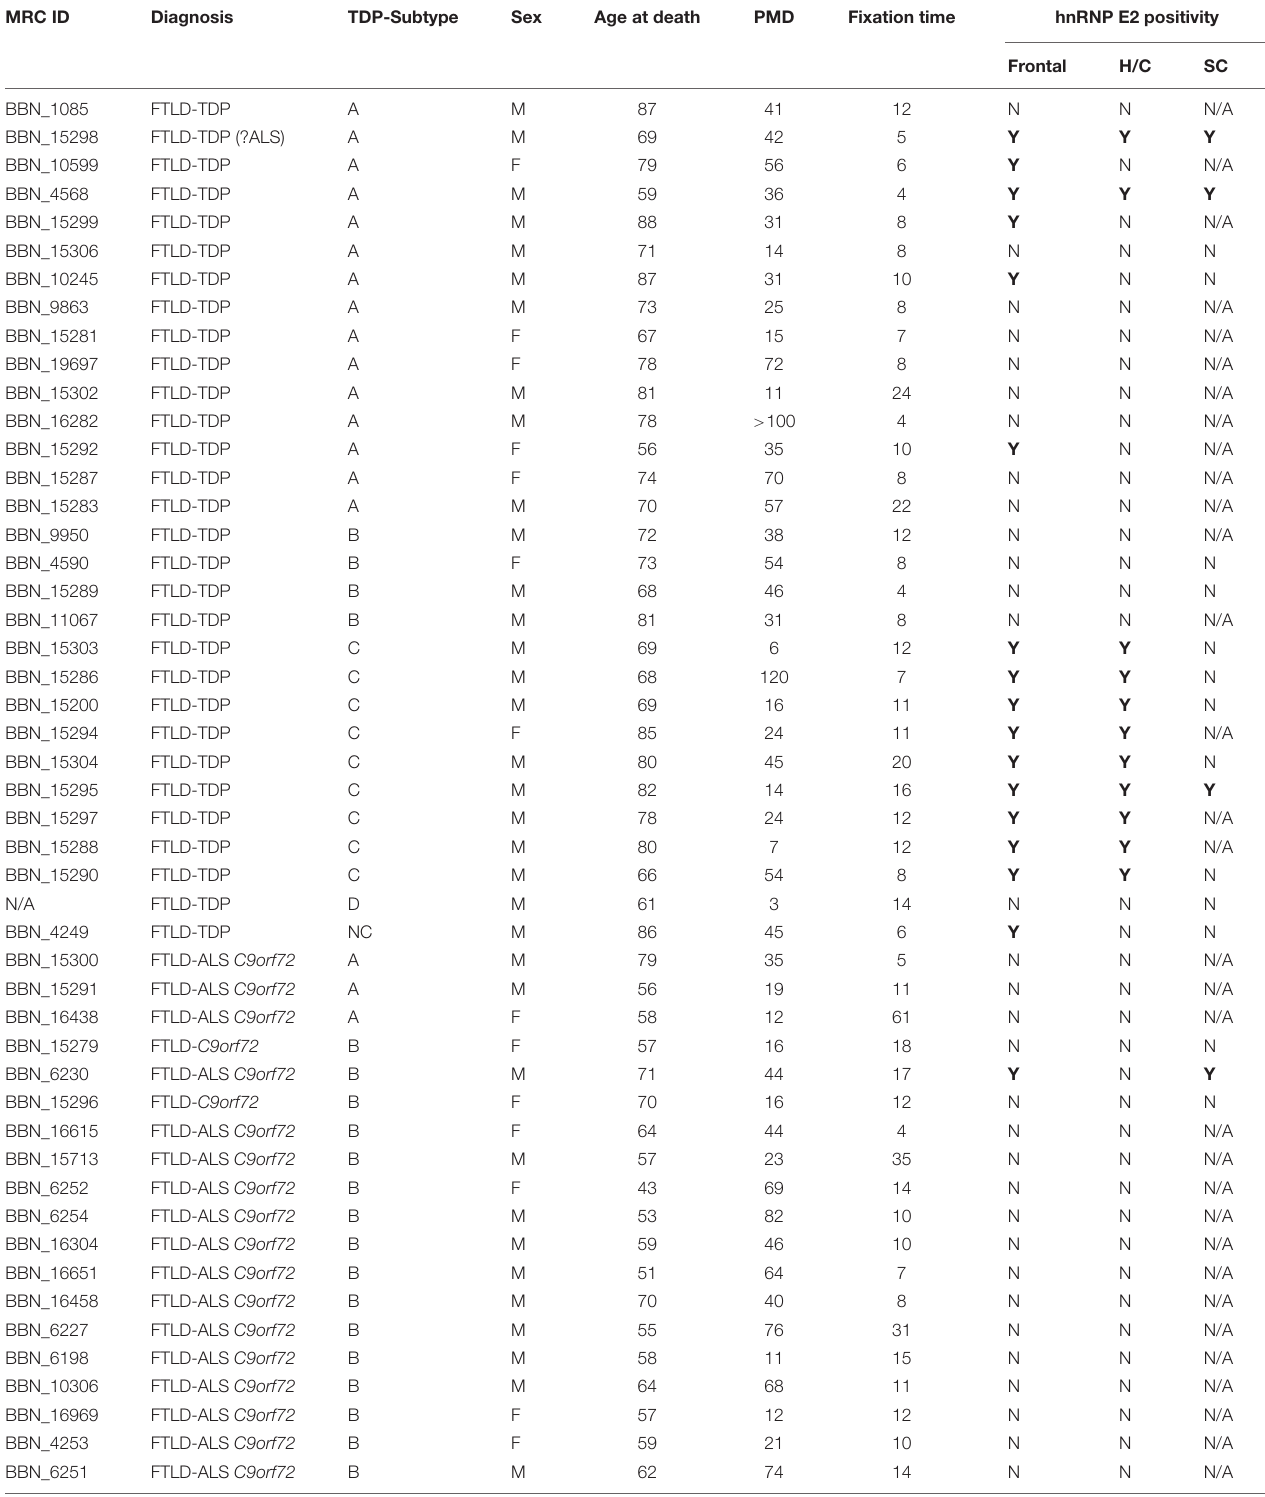
TABLE 1 | List of cases used in the study, showing demographic details and hnRNP E2 immunohistochemistry positivity. MRC